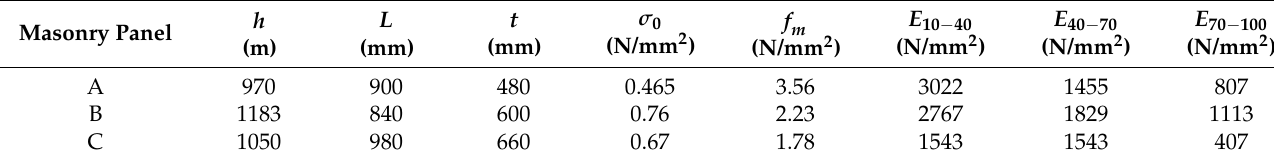
Figure 7. Tested stone masonry panels, Giotto ( a ), Cairoli ( b ), and Niccolini ( c ). Table 3. Characteristics of the investigated stone masonry